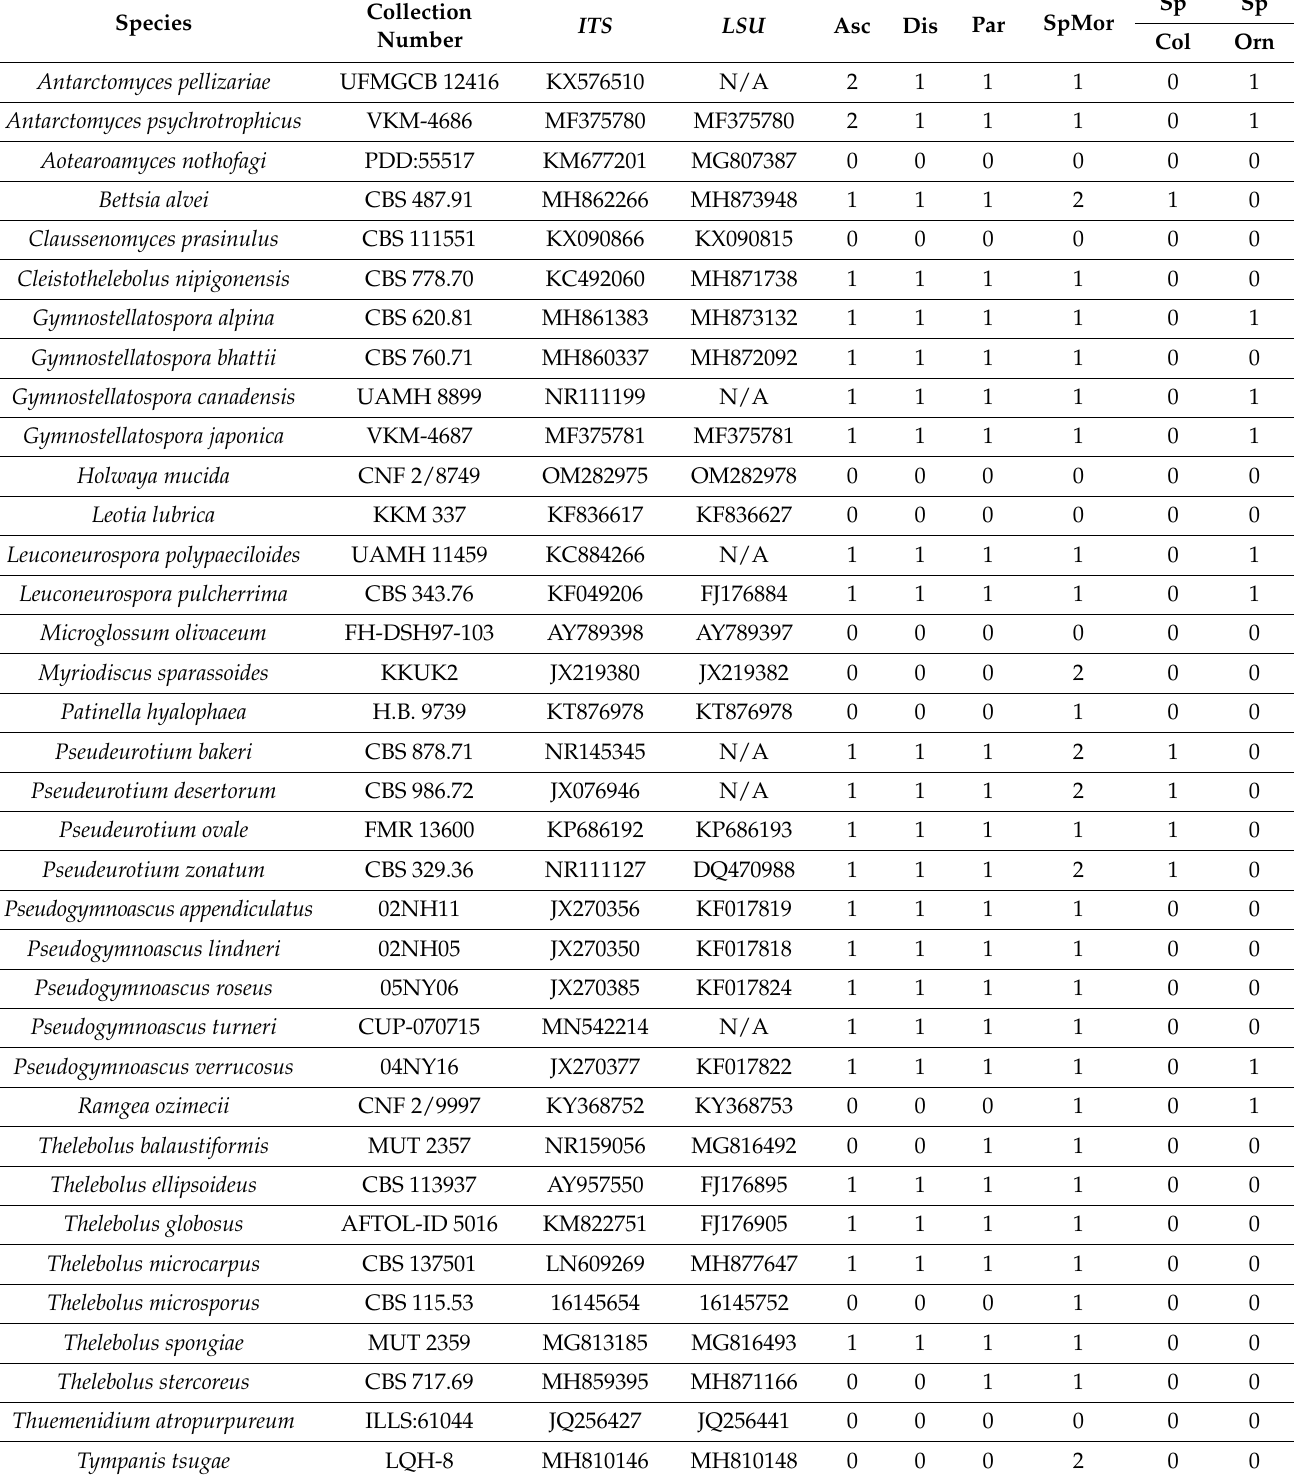
Table 1. A list of species, collection numbers, GenBank accession numbers used in this study, and phenotypic features with character states given for each species representative. N/A: not available. Asc = ascoma type; Dis = ascospore discharge; Par = paraphyses; SpMor = ascospore morphology; SpCol = ascospore color; SpOrn = ascospore